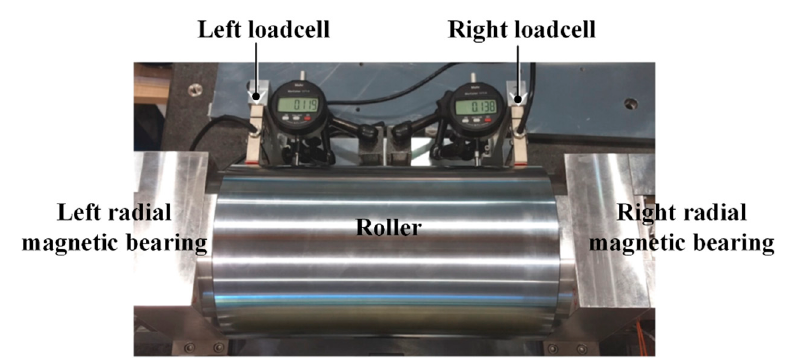
Figure 12. Experimental setup for automatic alignment test for the roller with magnetic bearings using load cells.